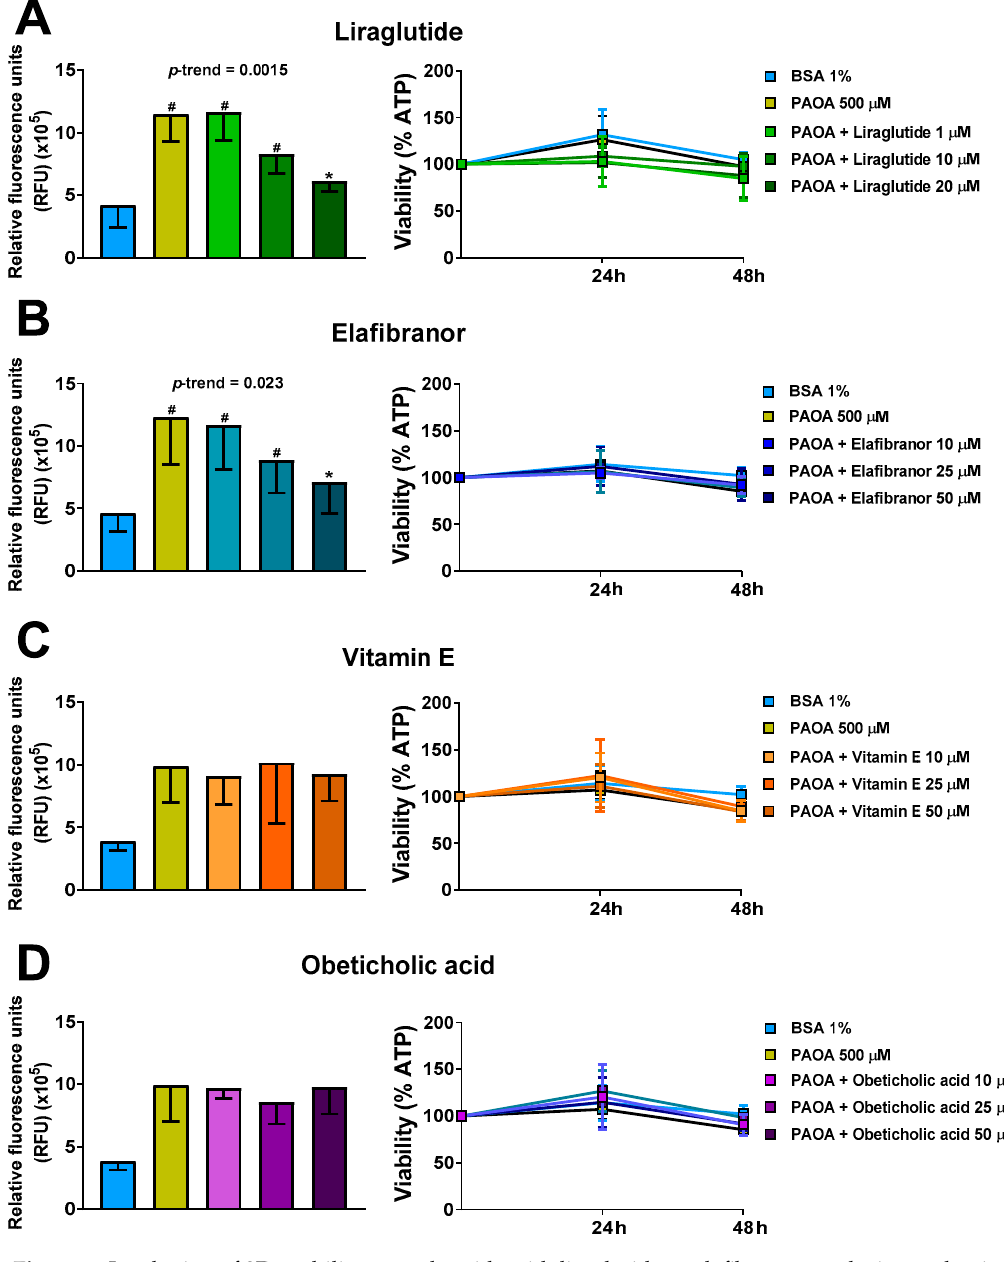
Figure 5. Incubation of 3D multilineage spheroids with liraglutide or elafibranor results in a reduction of intra-spheroid fat content. Prevention of steatosis by co-treatment with ( A ) Liraglutide (1, 10 and 20 µ M), ( B ) Elafibranor (10, 25, 50 µ M), ( C ) vitamin E (10, 25, 50 µ M) or ( D ) obeticholic acid (10, 25, 50 µ M) for 48 h in the presence of 500 µ M free fatty acids (PAOA) bound to BSA 1%. On the left panels, lipid levels were quantified using AdipoRed biochemical quantification assay. On the right panels cellular ATP levels, normalized to spheroids volumes, remained stable throughout 48 h of treatment ( n = 3). Bars represent mean ± SD. P-value was calculated by Mann-Whitney non-parametric test, (* p < 0.05 vs. PAOA 500 µ M; # p < 0.005 vs. BSA 1%). BSA: bovine serum albumin; PAOA: palmitic acid/oleic